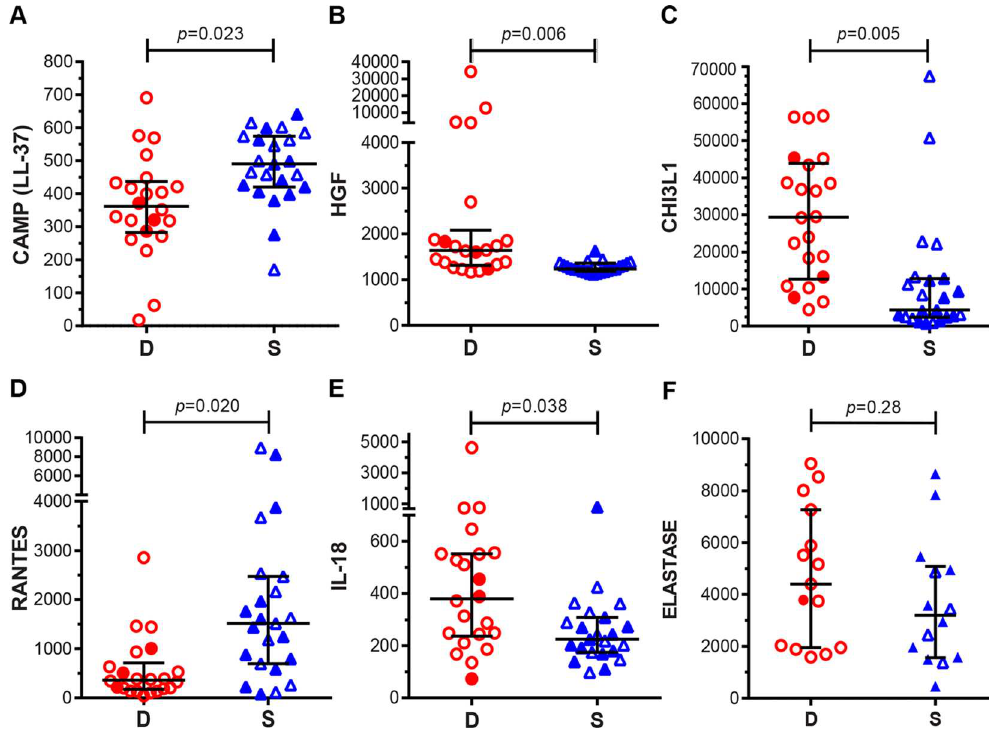
Fig 4. Serum protein levels validate expression profiles of specific gene products identified by microarray. Serum protein levels of cathelicidin(CAMP [LL-37]) (A) and RANTES (D) were higher in survivors, while HGF (B) and IL-18 (E) serum levels were higher in deceasedpatients. (C) Deceasedpatients had higher serum of CHI3L1 than survivors, in contrast to microarray results. (F) Elastase levels did not differ between outcomes. N = 23 for Survivors (S; blue triangles) and N = 22 for and deceasedpatients (D; red circles) for (A-E) . N = 14 for survivors and N = 15 for deceasedpatients in (F) . Filled symbols denote individualsincludedin microarray analyses. Values are medians +/- IQR in pg/mL (B-E) or ng/mL (A, F) .